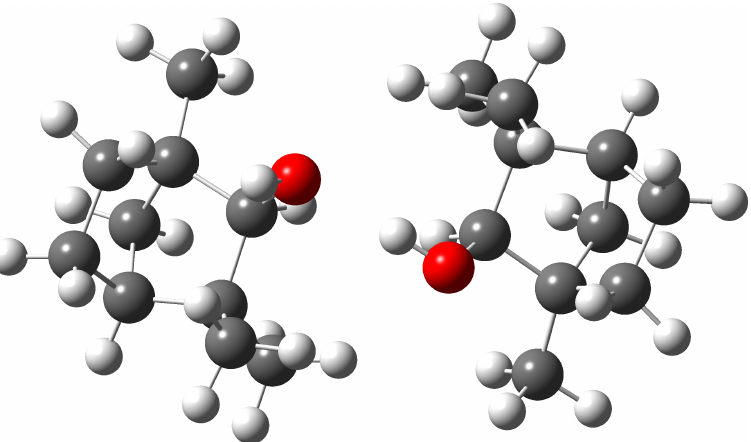
Figure 15. Most stable dimer of (+) - α -fenchol at B3LYP/may-cc-pVTZ level viewed along the approximate C 2 symmetry